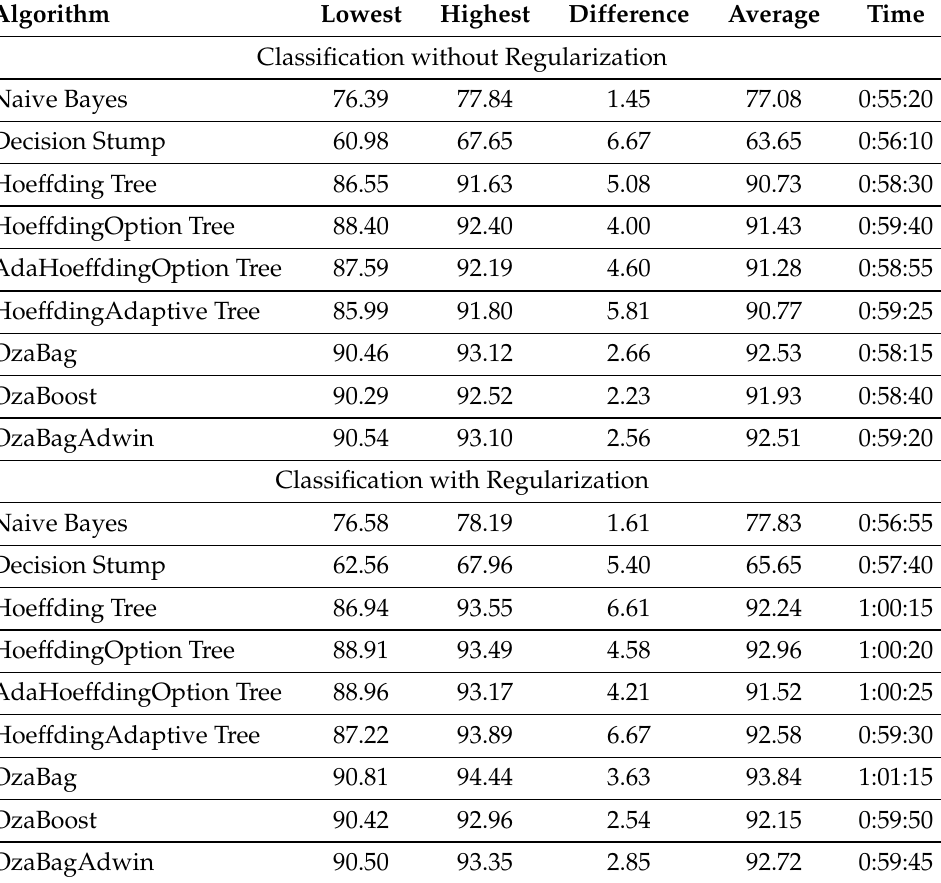
Table 6. Lowest, highest and average accuracy percentages of weather classification for dataset =